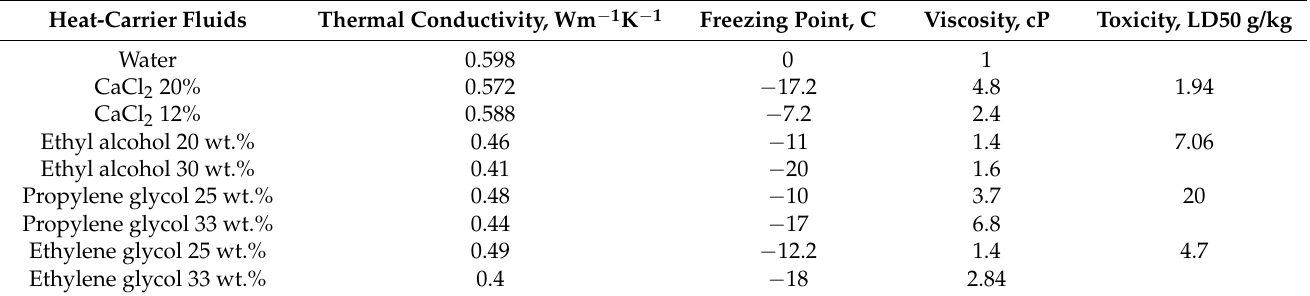
Table 2. Heat-carrier fluid Properties